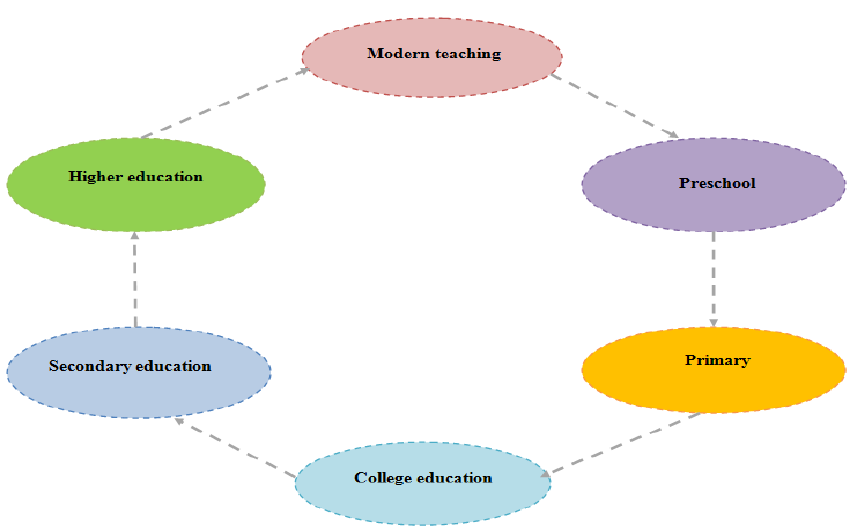
Fig. 1. The education system in Morocco includes pre-school, primary, secondary and univer- sity